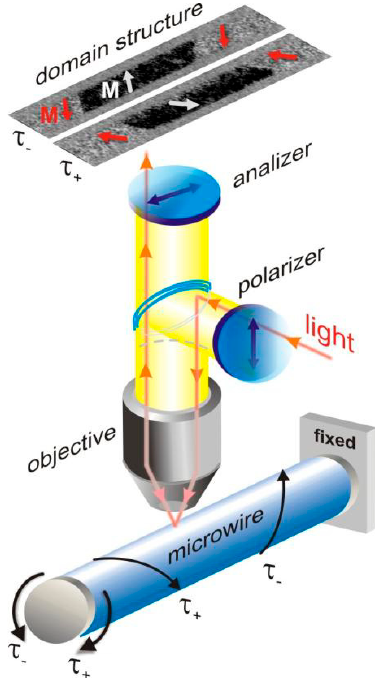
Figure 1. Schematic picture of MOKE geometry and application of torsion stress t + and t − . Reprinted with permission from [36].